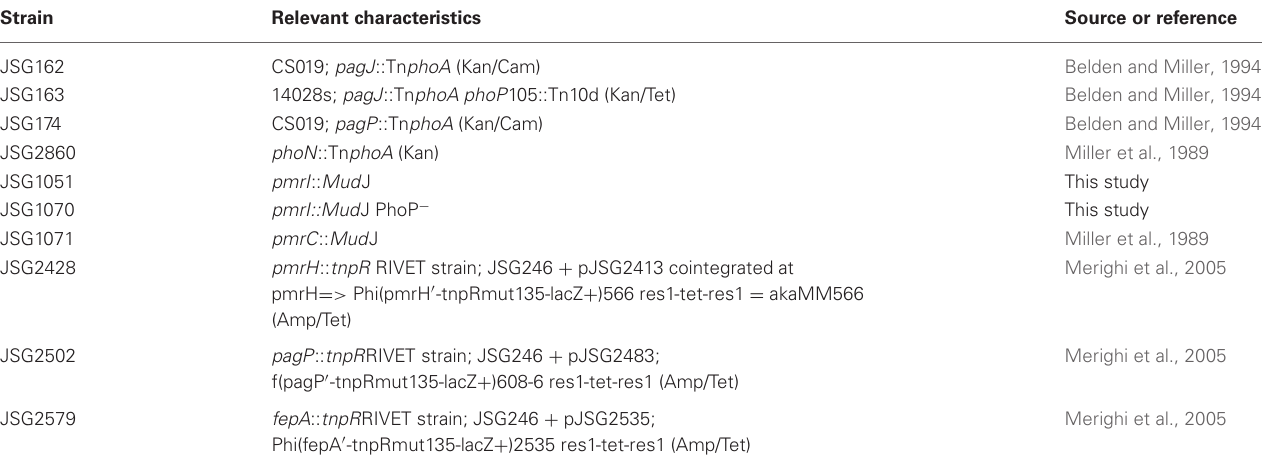
Table 1 | Salmonella enterica serovar Typhimurium